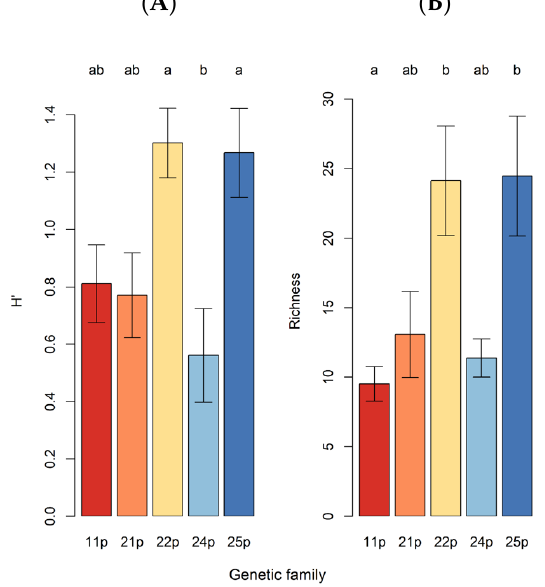
Figure 2. Shannon diversity (H (cid:48) ; ( A )) and OTU richness (Richness; ( B )) across maternal families. Bars are means, errors are SEMs. Different alphabetic letters above bars represent gene families with statistically different ( α = 0.05) population means after controlling for family-wise type I error using Tukey (cid:48) s HSD, with pooled variance based on omnibus mixed model estimates for σ 2 .